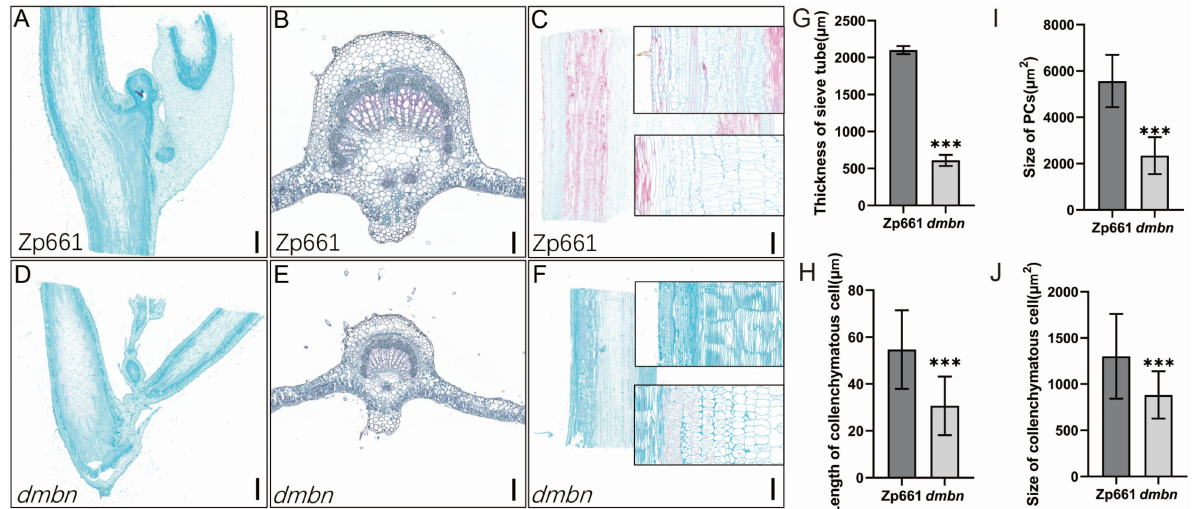
Figure 2. Cell elongation and expansion are defective in Zp661 and the dmbn mutant. ( A , D ) Axillary bud cross sections of Zp661 ( A ) and dmbn ( D ) from plants at the R5 stage; bar, 1000 µ m. ( B , E ) Main vein cross sections of Zp661 ( B ) and dmbn ( E ) from plants at the R5 stage; bar, 200 µ m. ( C , F ) Stem longitudinal sections of Zp661 ( C ) and dmbn ( F ) from plants at the R5 stage; bar, 1000 µ m. ( G – J ) Sta- tistical analysis of the sieve tube, collenchymatous cell and PCs (pith cells). Error bars ± SD (5 and 6 cells in Zp661 and dmbn of thickness of sieve tube; 65 and 60 cells in Zp661 and dmbn of pith cell length or size; 94 and 74 cells in Zp661 and dmbn of collenchymatous cell length. Student’s t -test was used for comparisons (*** p ≤